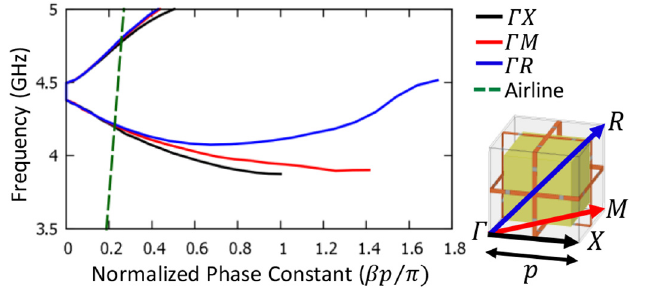
Fig. 3. Simulated dispersion diagram of the composite structure loaded with the lumped inductors ( L =1.5 nH).